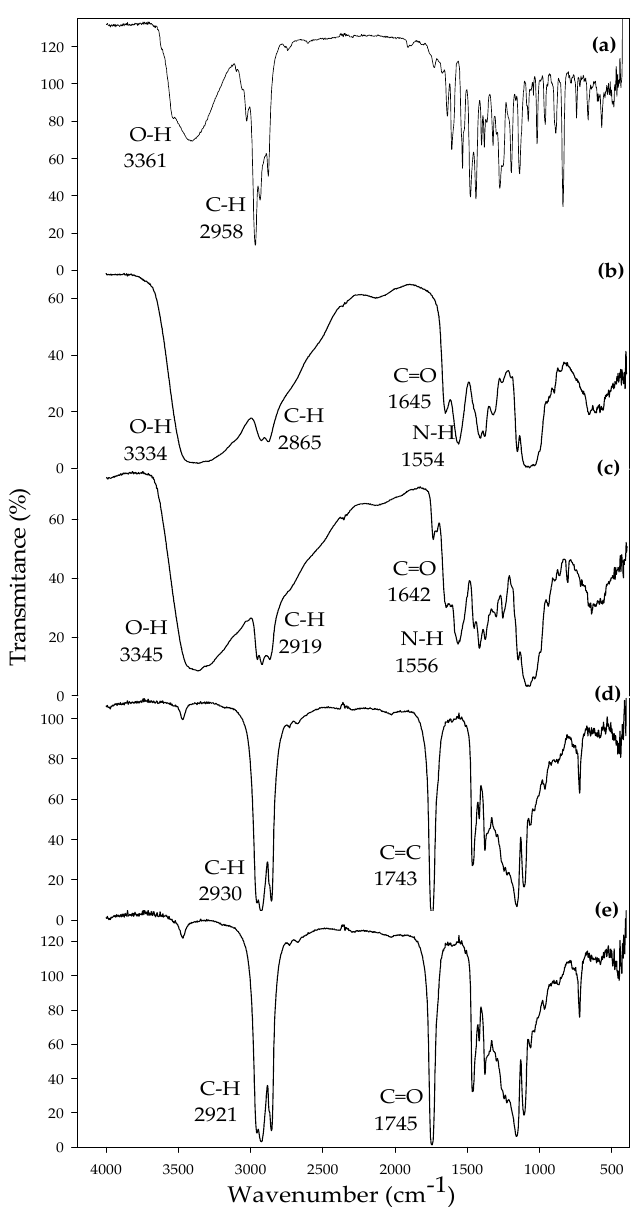
Figure 1. Fourier transform infrared spectroscopy (FTIR) spectra of oregano essential oil (OEO) ( a ), chitosan ( b ), chitosan-OEO ( c ), wax ( d ), and wax-OEO ( e ) films.